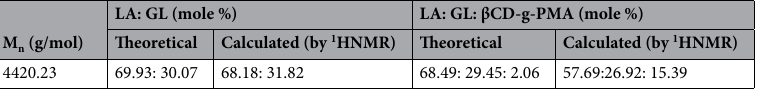
Table 1. M n value for copolymer calculated using 1 HNMR, with theoretical and spectrum-based calculated (by 1 HNMR) molar ratio of βCD-g-PMA-co-PLGA copolymer sections.